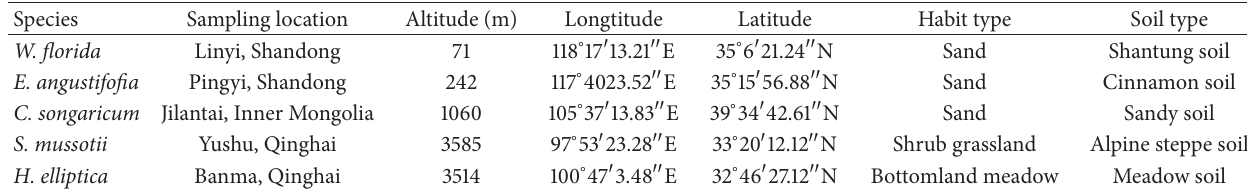
Table 1: Sampling sites and plant